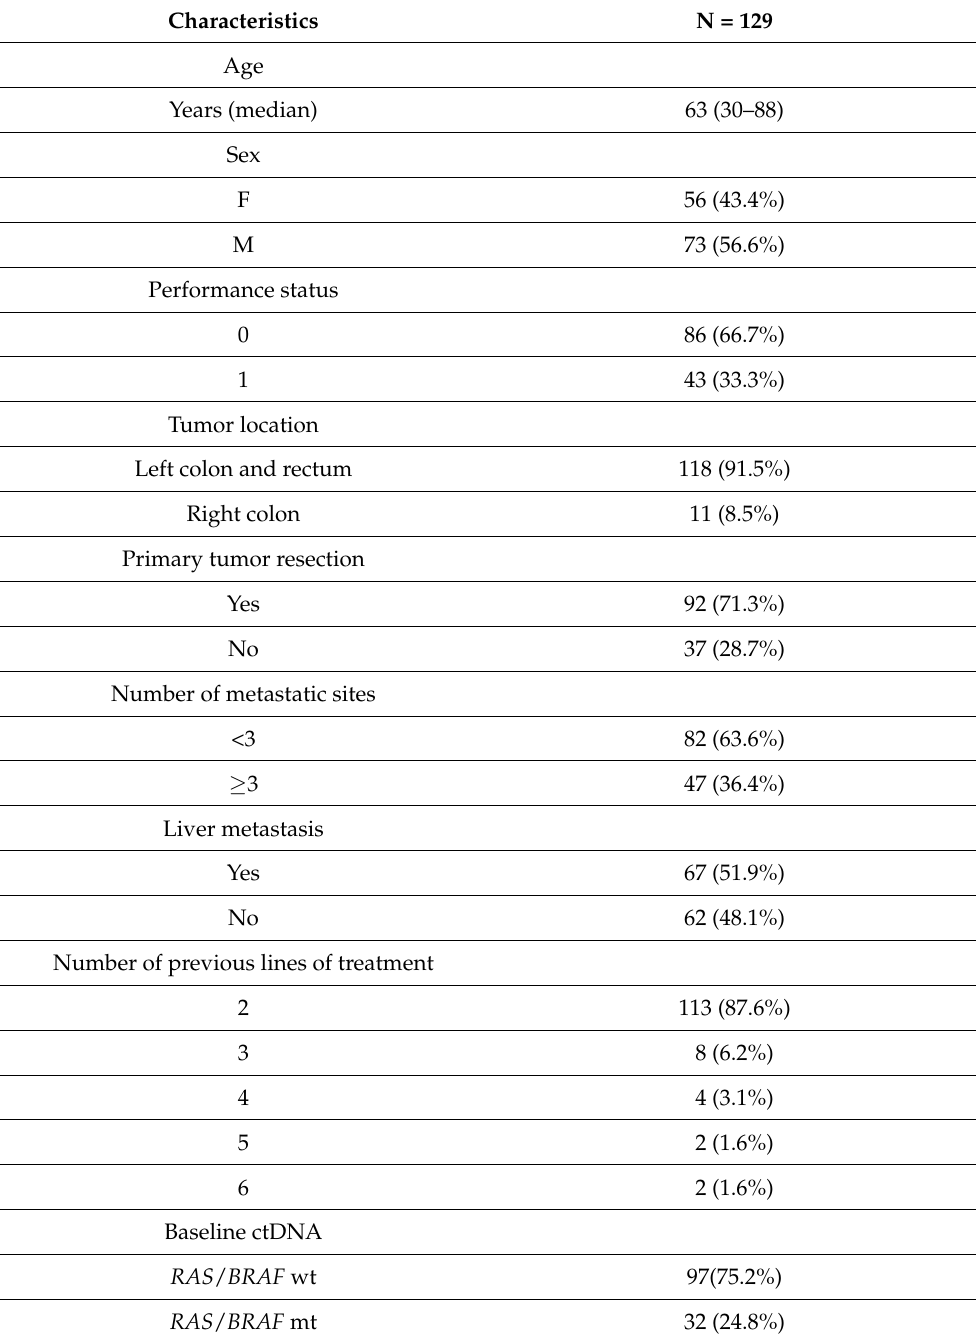
Table 1. Characteristics of the study population. F: female; M: male; ctDNA: circulating tumor DNA; WT: wild type; MT: